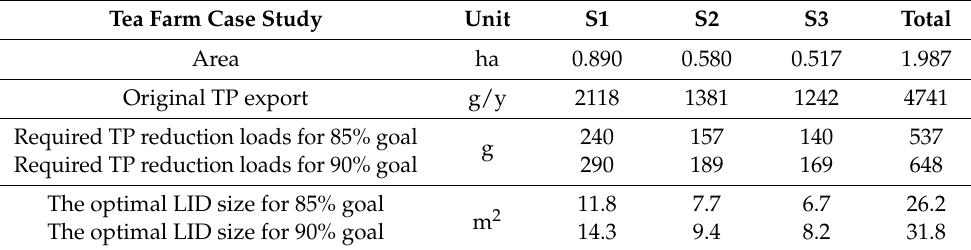
Table 6. The optimal LID size suggested for the tea farm case